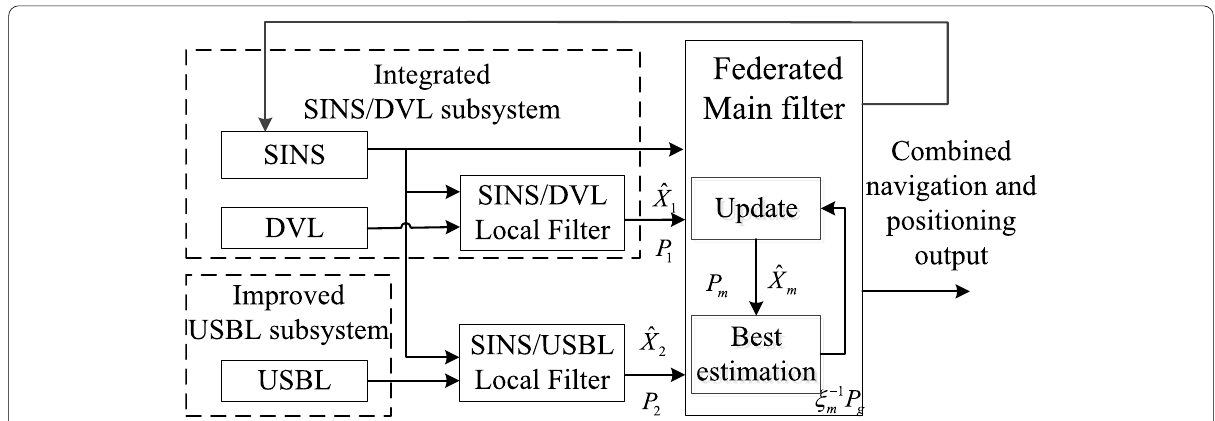
Fig. 7 The framework of the improved federated combined filtering based navigation and positioning